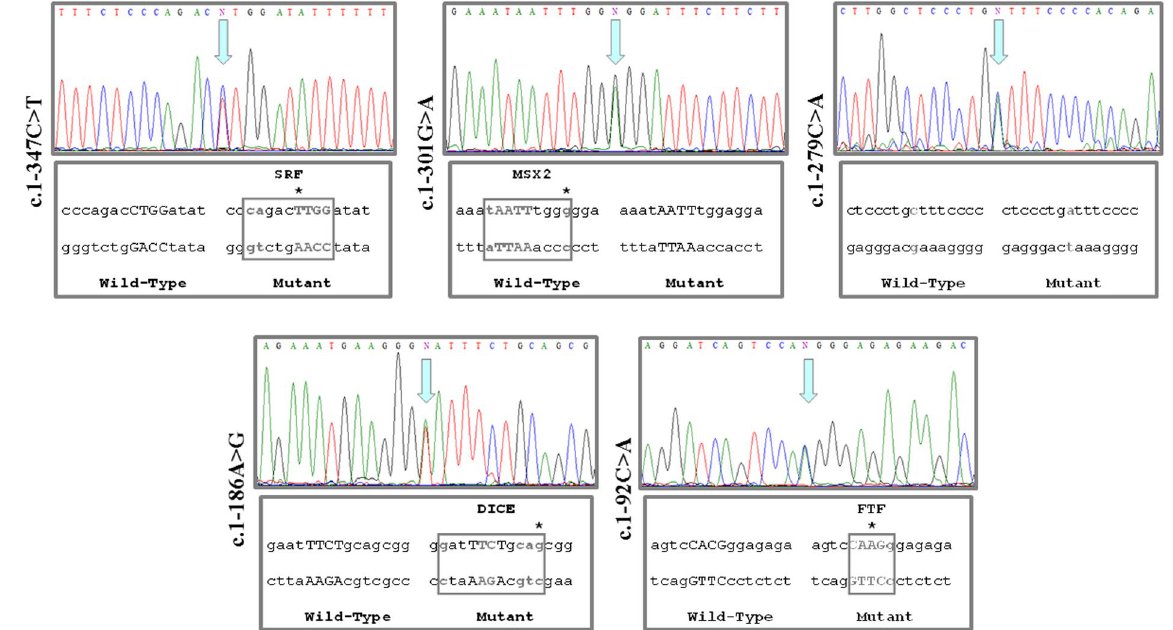
Figure 2. Representative sequence electropherograms for the mutations in 5 ′ UTR of BMPR2 gene (c.1- 347C > T, c.1-301G > A, c.1-279C > A, c.1-186A > T and c.1-92C > A) in PAH patients and In silico analysis of the effect on the binding site to transcriptions factors of variants found in 5 ′ UTR region of BMPR2 gene. MatInspector software found that these variants could create (SRF, DICE and FTF) or remove (MSX2) new binding sites for different factors. c.1-279C > A seems to not the binding sites to transcriptions